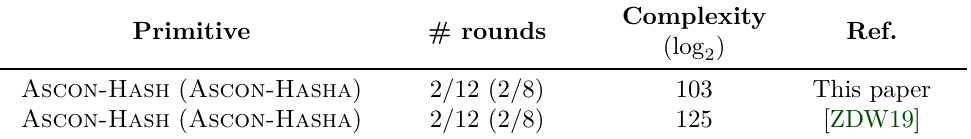
Table 9: Summary of collision attacks against Ascon-Hash ( Ascon-Hasha